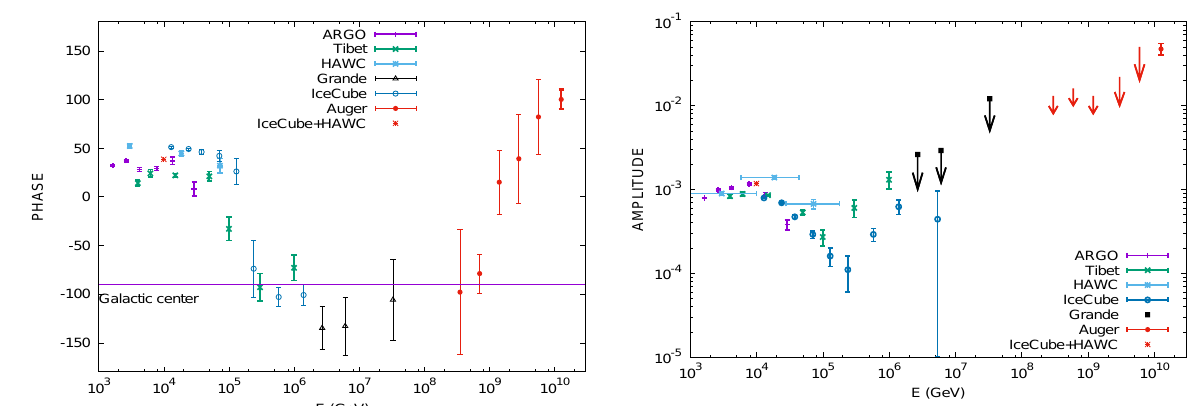
Figure 1. The dipole component of the CR anisotropy as function of energy: the phase (left panel) and the amplitude (right panel); adopted from Ref.